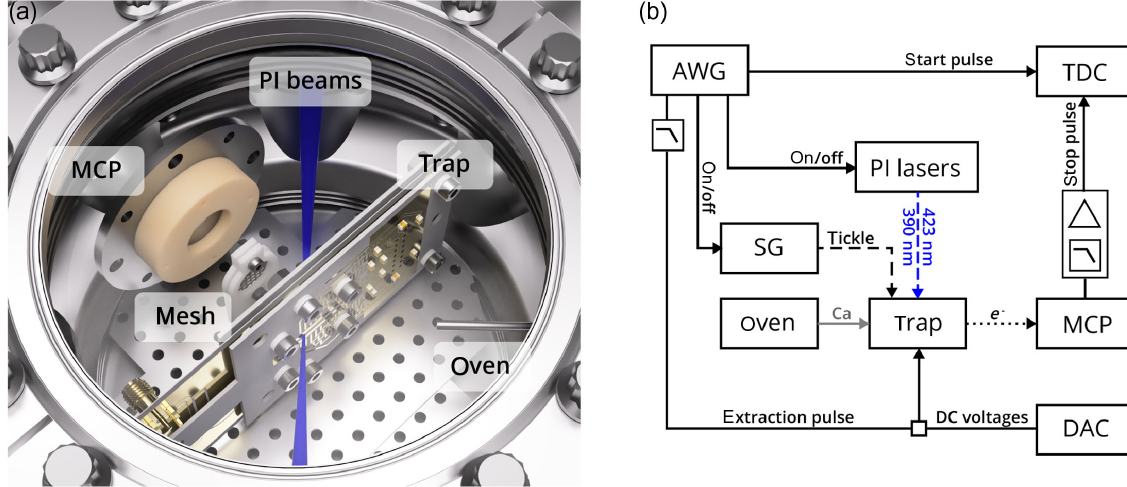
FIG. 3. Experimental setup and control schematic. (a) Simplified rendering of the setup inside the UHV chamber, showing the electron trap, a microchannel plate (MCP) detector, a mesh, the path of the PI beams, and an oven supplying calcium for ionization. (b) Key elements for experiment synchronization. An arbitrary waveform generator (AWG) provides the extraction pulses to the trap and the start signal for a time-to-digital converter (TDC). It controls the timing for pulsing on and off the PI loading beams and a signal generator (SG), which excites the electron motion ( “ tickle ” ). Pulses from the MCP provide the stop signals to the TDC. Low-pass filters prevent electronic pickup of the microwave trap drive and the extraction pulses by the MCP detection circuit, which contains pulse shaping and amplification elements. The Ca oven and a digital-to-analog converter (DAC) for the dc trap voltages are operated with constant settings during an